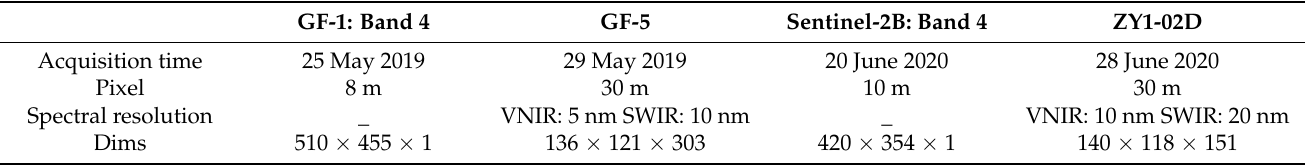
Table 1. The basic information of the images used in this study.